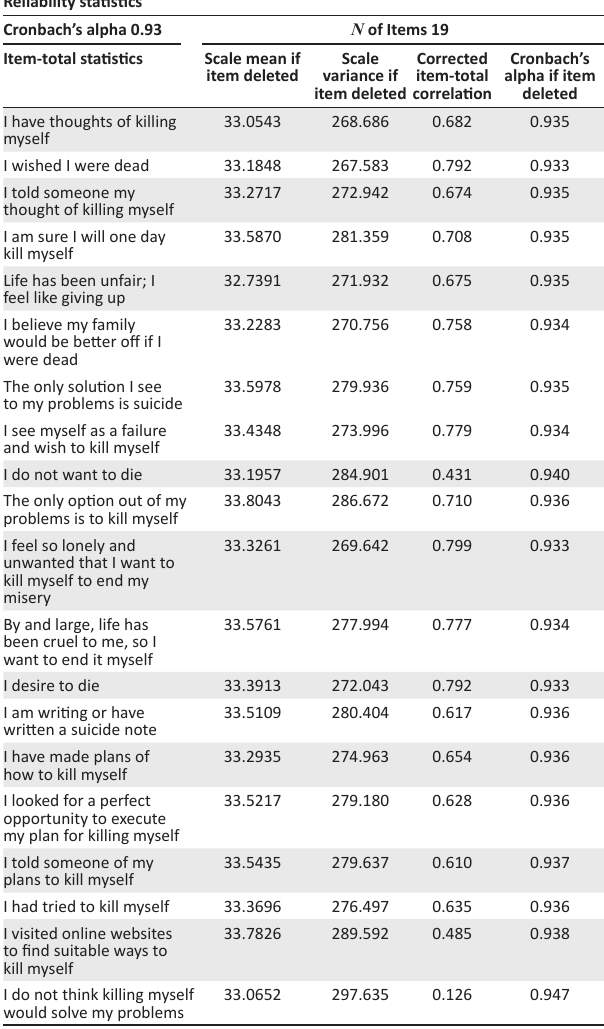
TABLE 4: Item-total statistics of the Redeemer’s University Suicidality